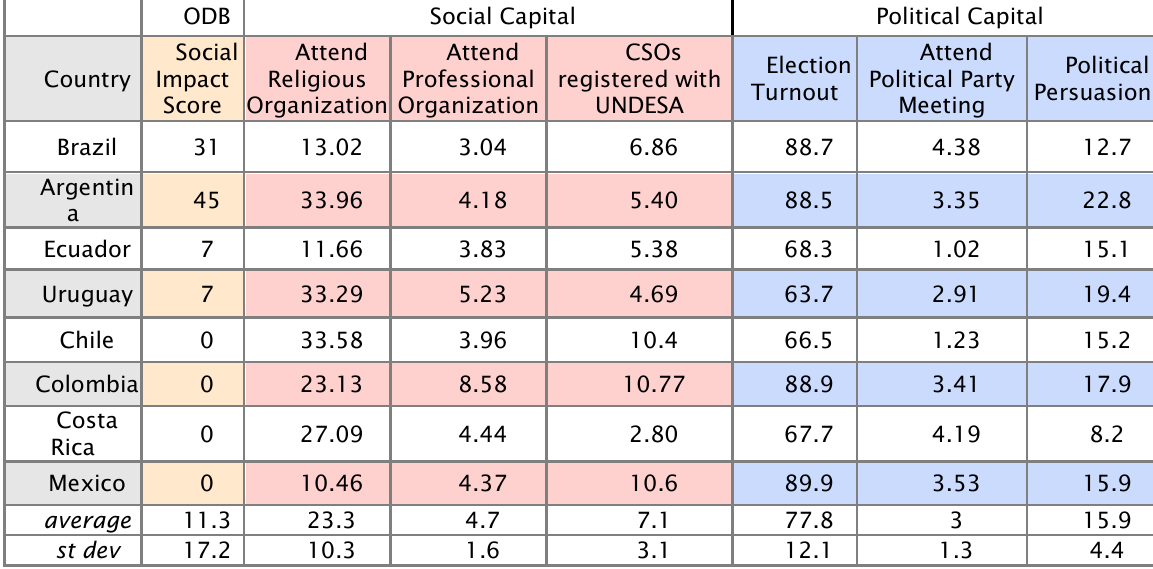
Table 1. ODB, Social Capital, and Political Capital Summary Statistics